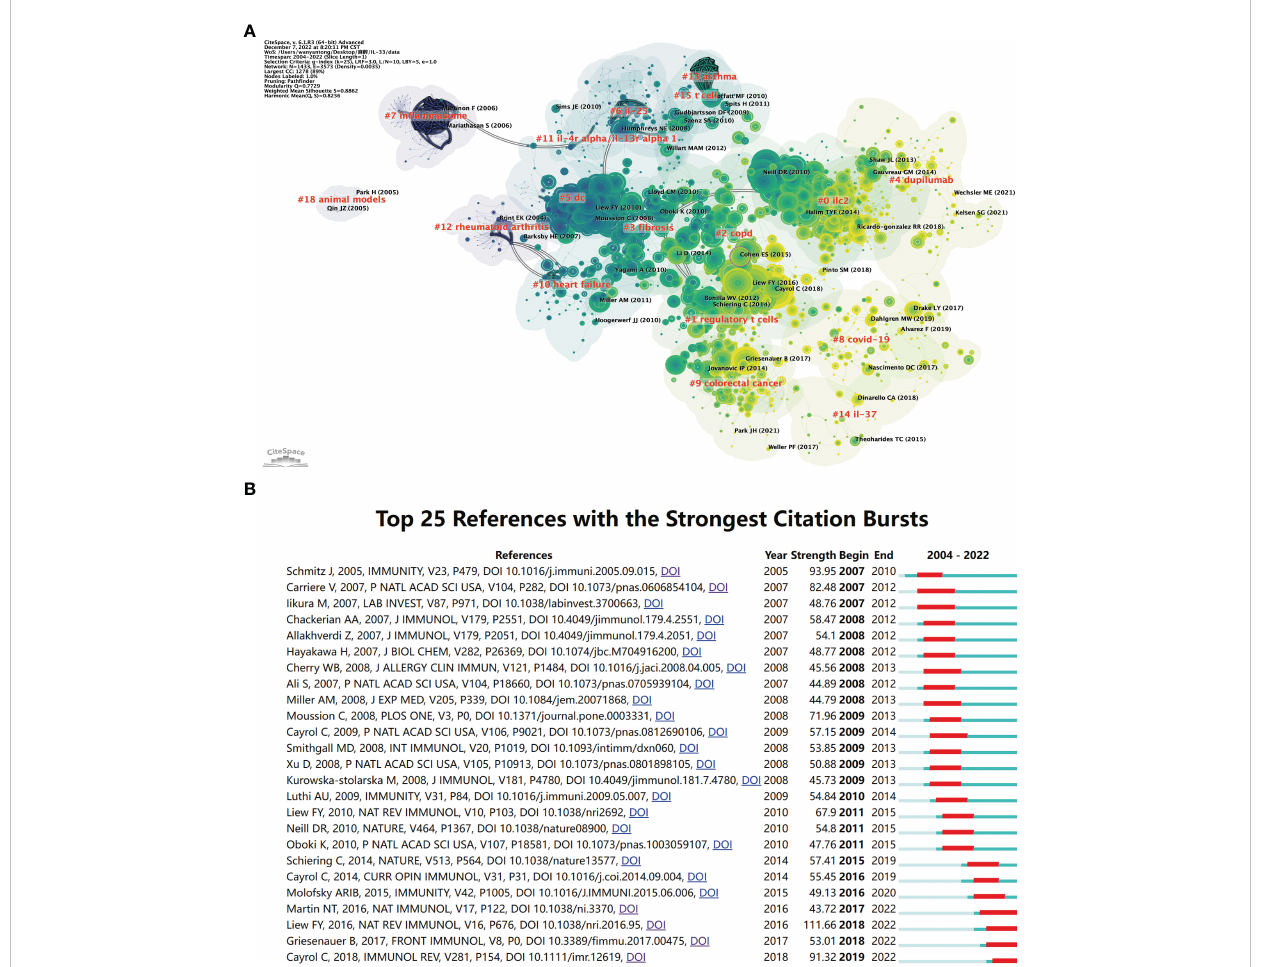
FIGURE 6 The analysis of references related to IL-33. (A) Clustering of references based on the similarity between references, including #0 ilc2, #1 regulatory t cells, #2 copd, #3 fi brosis, #4 dupilumab, #5 dc, #6 il-25, #7 in fl ammasome, and so on. (B) The top 25 references with strong citation bursts. A red bar means high citations in the corresponding year.